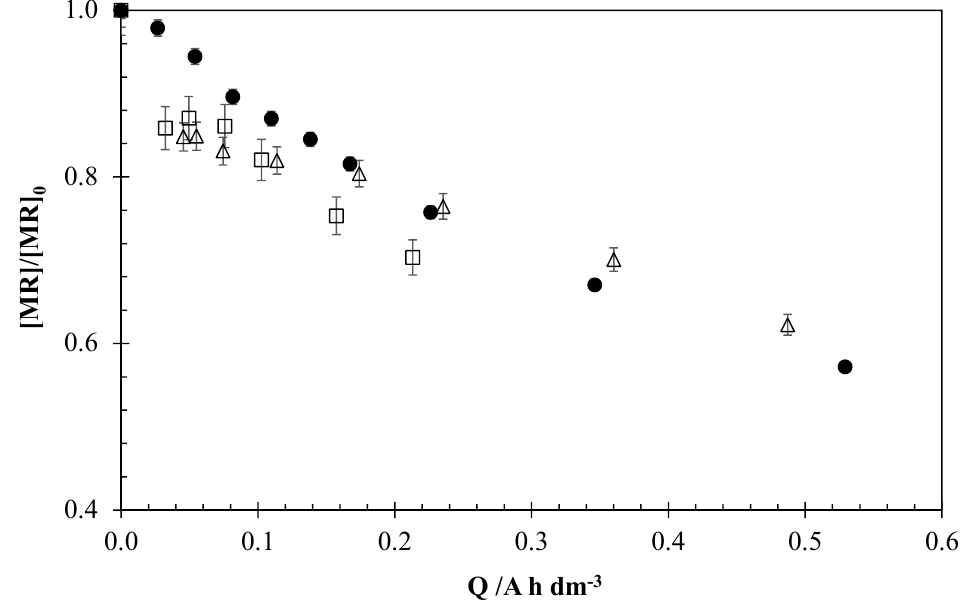
Figure 3. Influence of the applied current density on the EO of MR. Operation conditions: [MR] 0 = 5 mg dm − 3 , 0.051 M NaCl. ( □ ) 2 mA cm − 2 , ( Δ ) 5 mA cm − 2 , ( ● ) 15 mA cm − 2 .